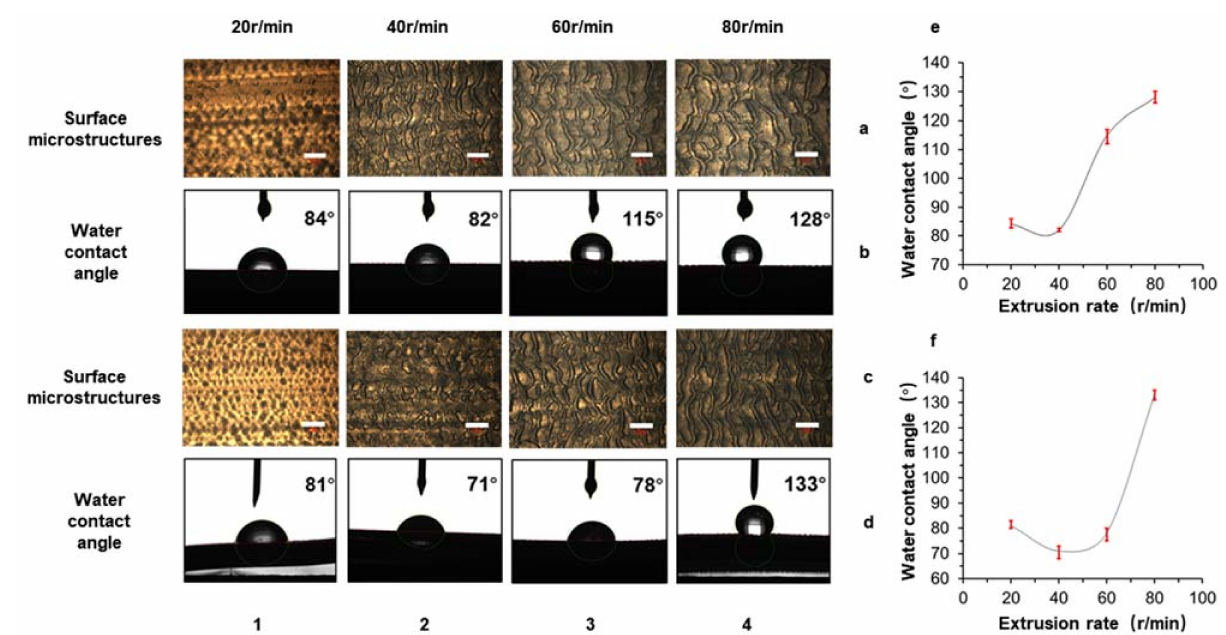
Figure 6. ( a ) When LLDPE/AC15 (9:1) was used as the material and the die temperature was 155 ◦ C, the changes in the morphology and water contact angle of the prepared sample with screw speed on the micrometer scale ( b ). ( c ) When LLDPE/AC5 (9:1) was used as the material and the die temperature was 160 ◦ C, the changes in the morphology and water contact angle of the prepared sample with screw speed on the micrometer scale ( d ). ( e ) The relationship between the screw speed and hydrophobic properties of the samples prepared in the case of LLDPE/AC15 (9:1). ( f ) The relationship between the screw speed and hydrophobic properties of the samples prepared in the case of LLDPE/AC5 (9:1). The scale bar in the illustration of ( a , c ) was 400 µ m. (1–4) respectively showed that the screw speed was 20 r/min, 40 r/min, 60 r/min, 80